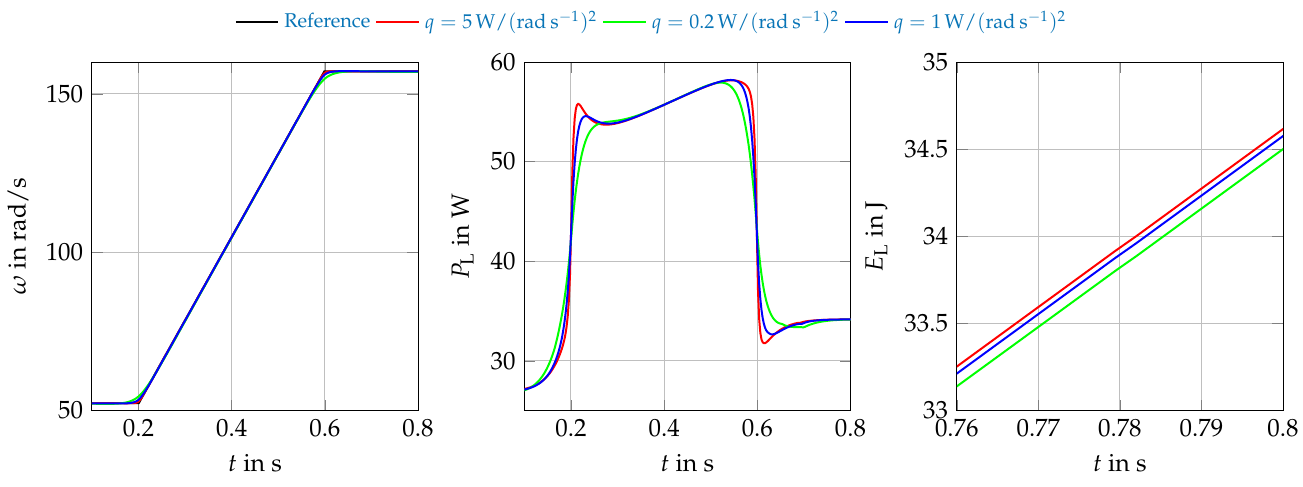
Figure 4. Offline optimization results for different values of q